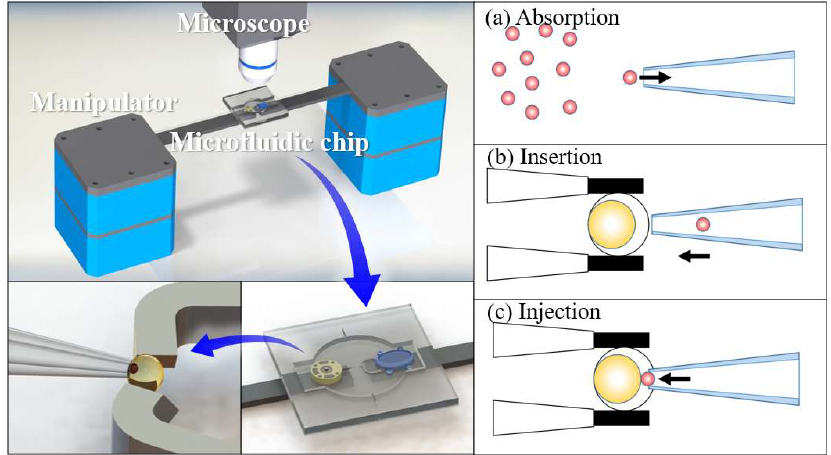
Figure 1. Millirobot system and process to inject cell nucleus into recipient cell.